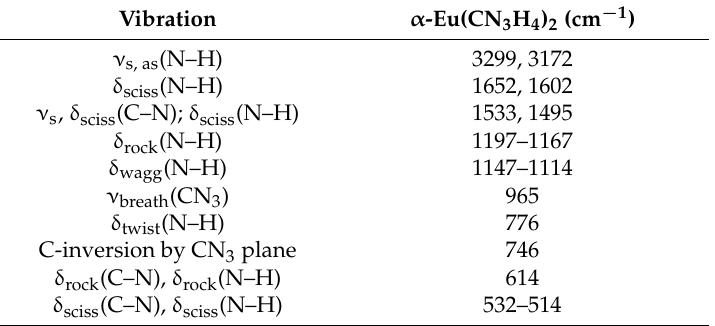
Figure 3. IR measurement of the β - (with an offset) and α -polymorphs of Eu(CN 3 H 4 ) 2 and simulation of the latter. Table 1. Assignment of vibrational bands of α -Eu(CN 3 H 4 ) 2 as obtained with density-functional theory (DFT).